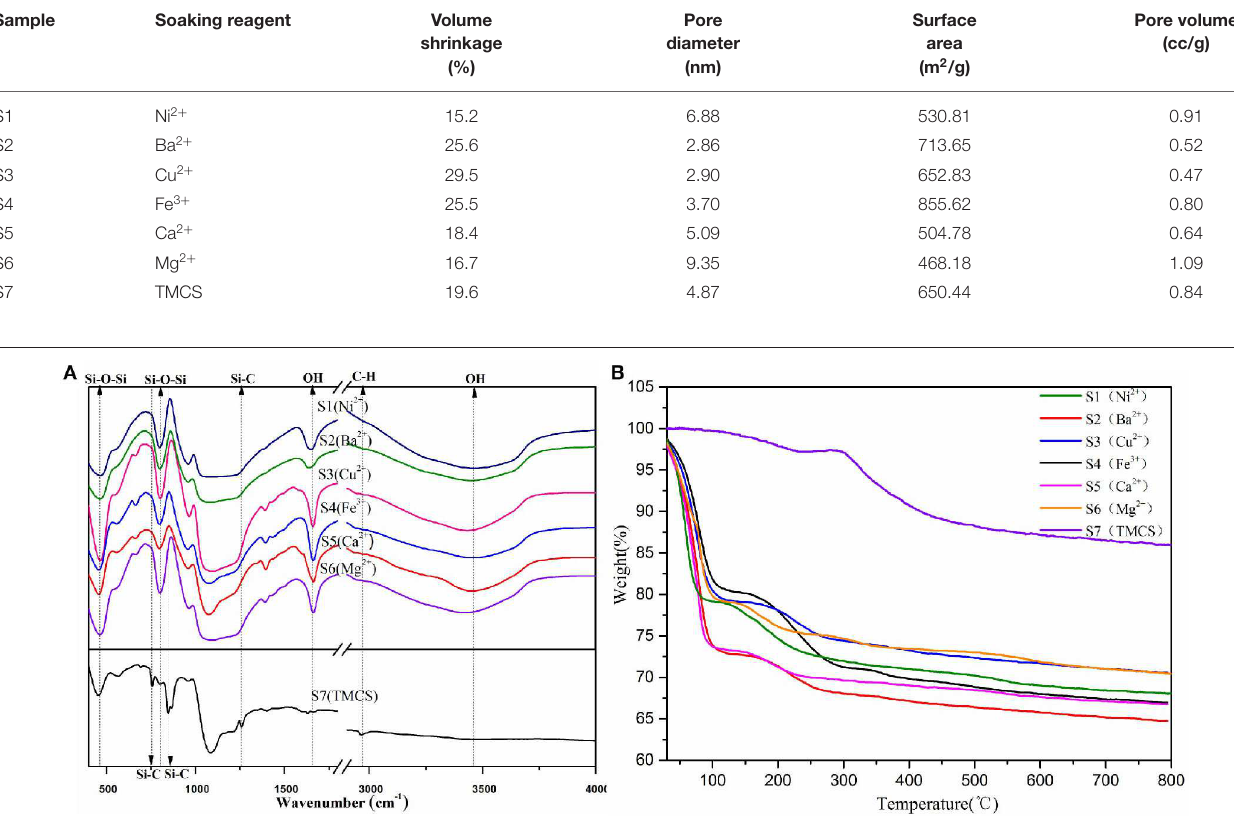
Figure 4C . During the soaking phase, the metal ions